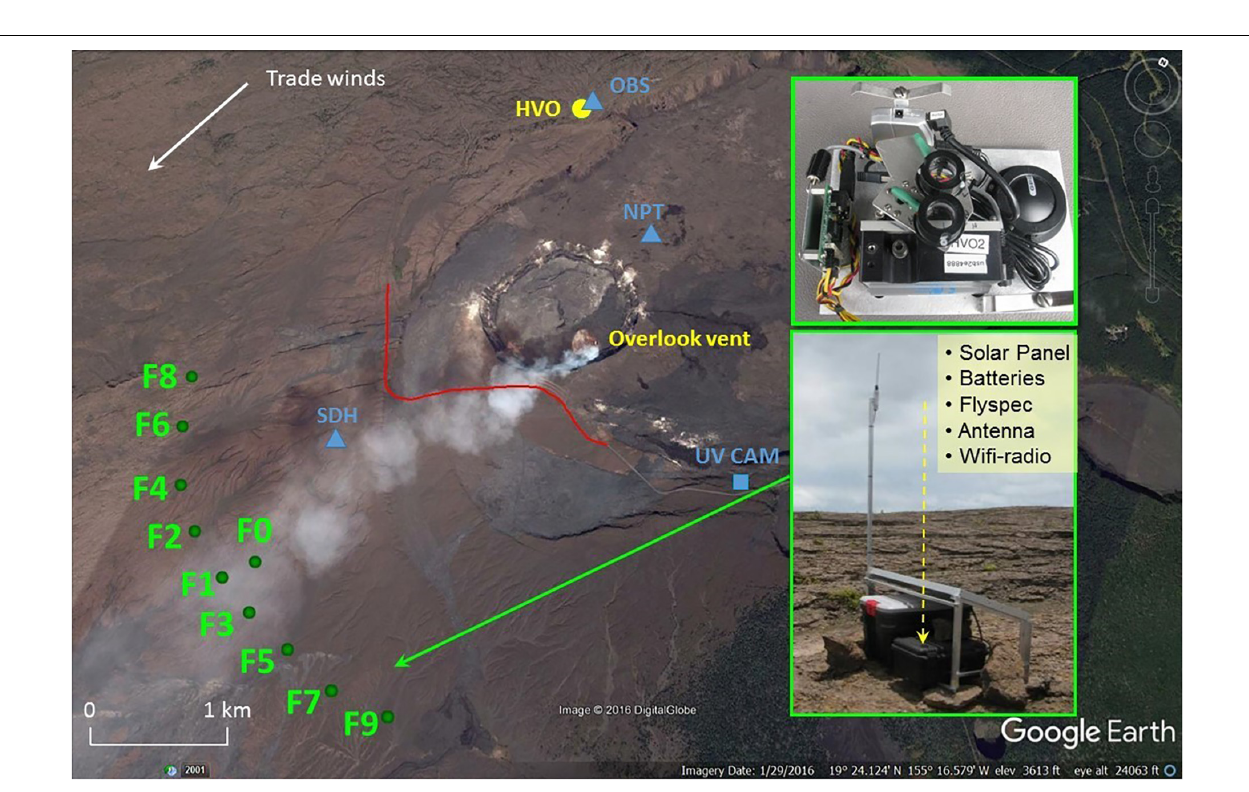
FIGURE 2 | Location of 10-spectrometer upward looking FLYSPEC array downwind of the summit of K¯ılauea (F0–F9), with station and instrument inset, ground-based anemometers and UV camera used for approximating plume speed (blue), traverse route on Crater Rim Drive (red), 2014–2017 location of Hawaiian Volcano Observatory and Overlook vent (yellow). Dominant trade wind direction indicated by arrow in upper